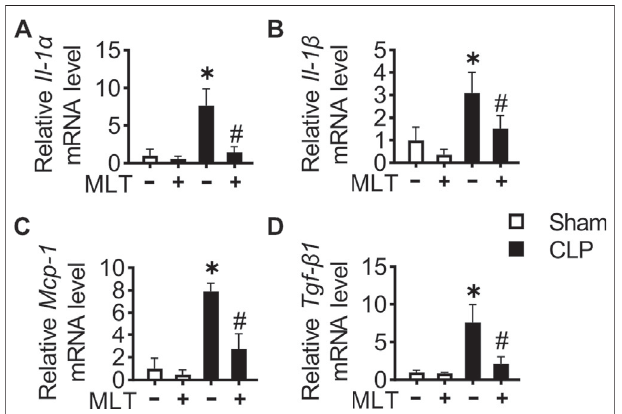
FIGURE 2 | Melatonin relieves in fl ammation in CLP-induced mice. Kidney tissue in fl ammatory cytokine Il-1 α (A) , Il-1 β (B) , Mcp-1 (C) , and Tgf- β 1 (D) mRNAlevelsaremeasuredusingRT-PCR(*vs.sham, p < 0.05;#vs.CLP, p <